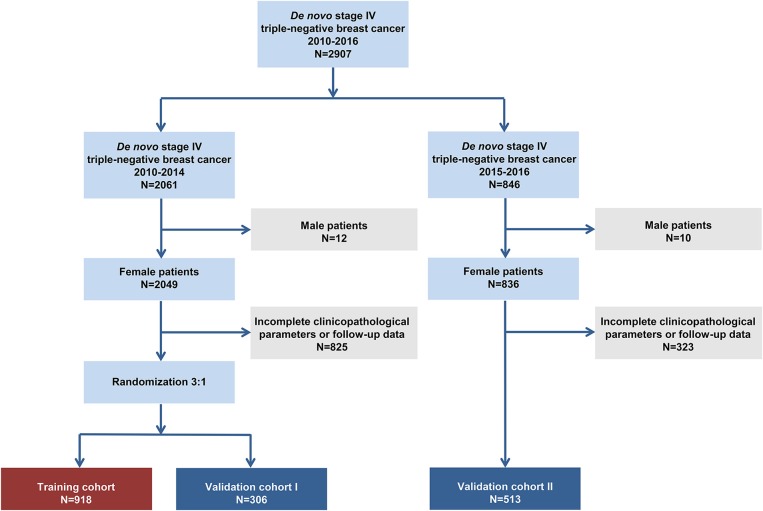
Patient selection flowchart.